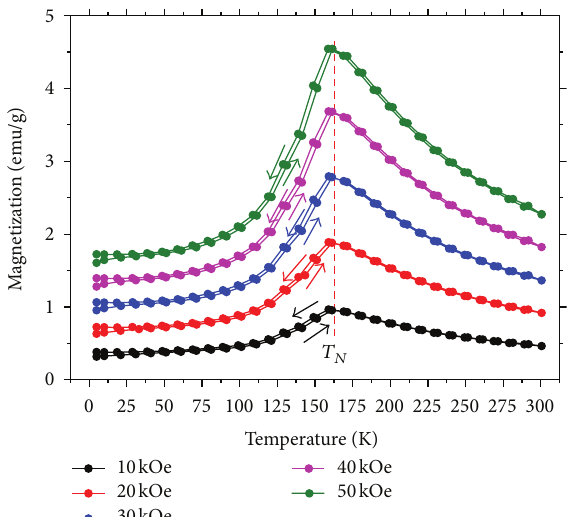
Figure 2: Temperature-dependent magnetization 𝑀(𝑇) of Mn 3 Zn 0.9 Cu 0.1 N measured during both FC and ZFC processes at several magnetic fields. The arrows indicate the direction of temperature circle.